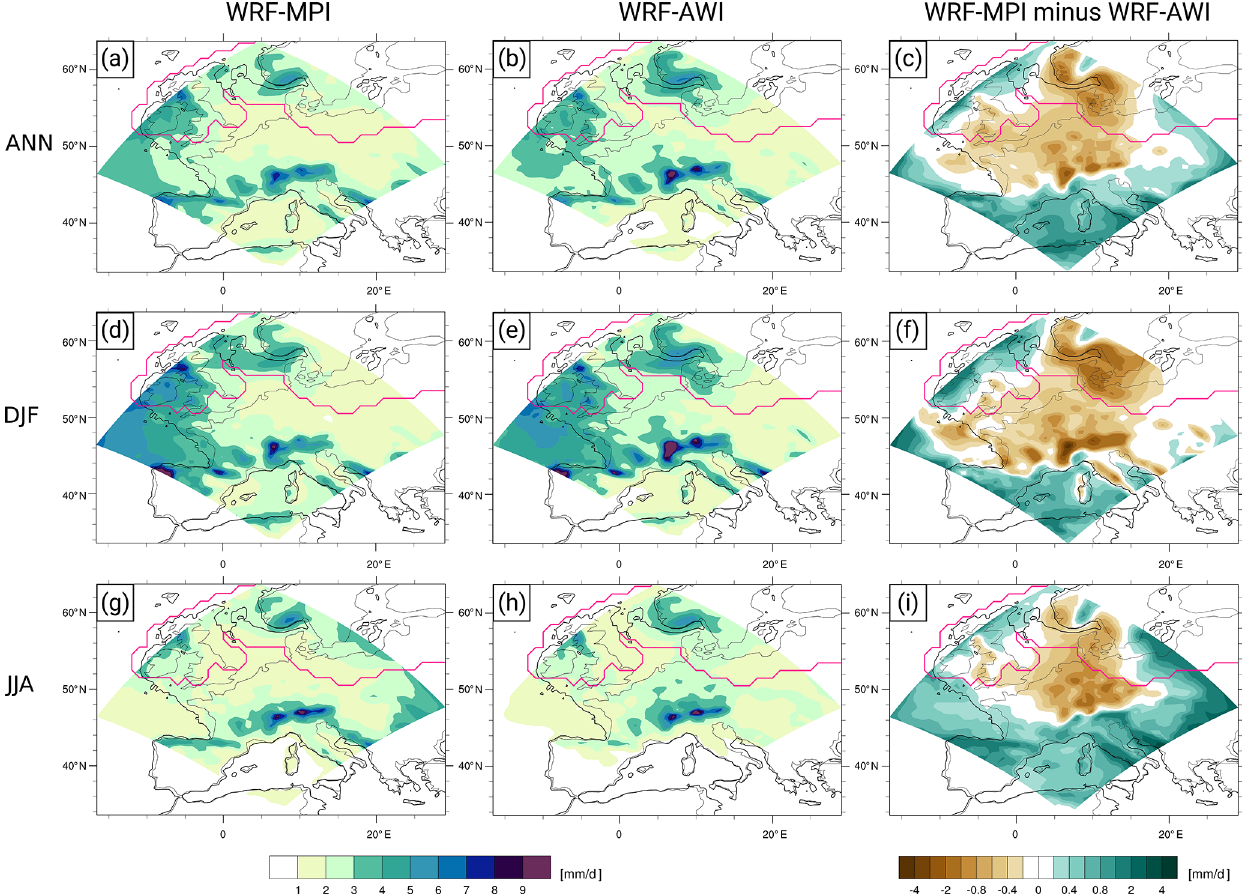
Figure 4. Distribution of total precipitation in annual (a–c) and seasonal winter (d–f) and summer (g–i) means as simulated with the regional WRF model with MPI forcing ( a , d , and g ) and with AWI forcing ( b , e , and h ) as well as their differences ( c , f , and i ). The black line shows the LGM coastline, and the pink line denotes the LGM ice